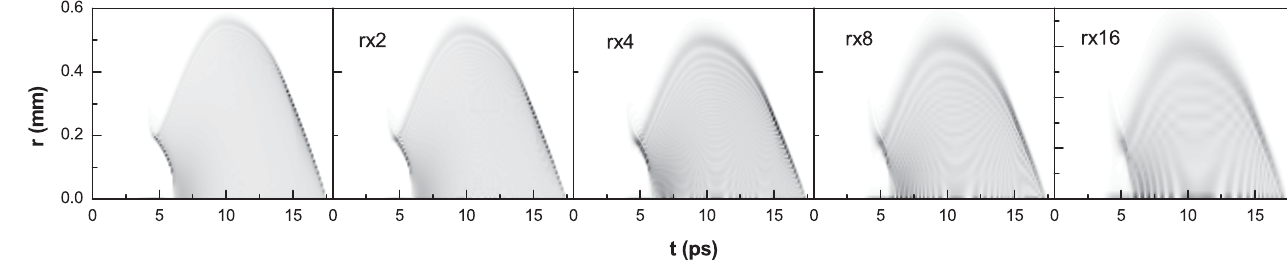
FIG. 2. (Color) Theoretically calculated spatiotemporal laser profiles with different input bandwidth with P ¼ 25 mm input beam (flat topped) using the same (cid:6) and (cid:7) as in Fig. 1(c). From left to right: (cid:1) !=! ¼ 8% , 4%, 2%, 1%, and 0.5%. Note the different scales in r in each panel.